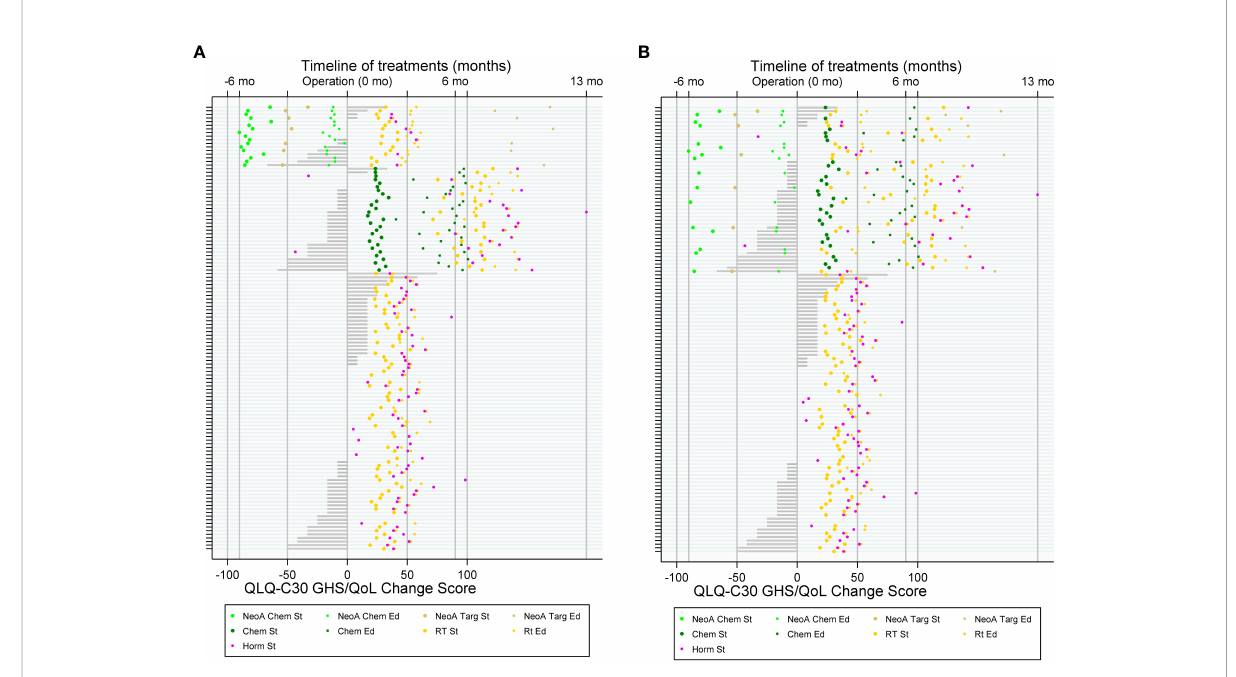
FIGURE 2 Treatment fl ow of patients with breast cancer (BC) and patient-reported outcome (PRO) with QLQ-C30 Global Health Status (GHS) change score. (A) By three groups: with neo-adjuvant chemotherapy (top), with adjuvant chemotherapy (middle), and without chemotherapy (bottom); (B) by two groups: with and without